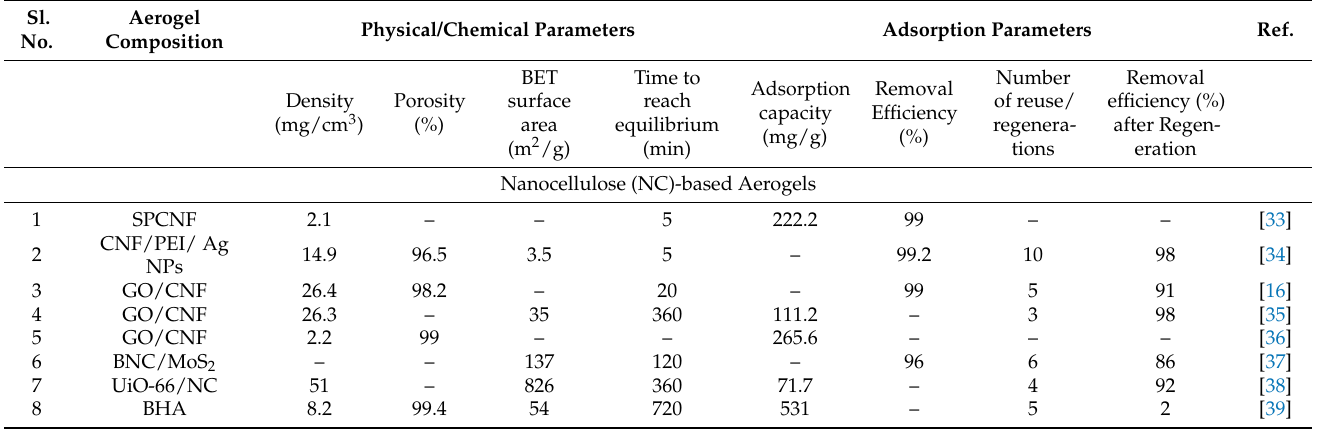
Table 1. Nanocellulose (NC)-, chitosan (CS)-, and Graphene (G) oxide-based aerogels in dye removal; physical/chemical and adsorption parameters. (Adapted from Paul and Ahankari Ref. [6], copyright (2023), with permission from